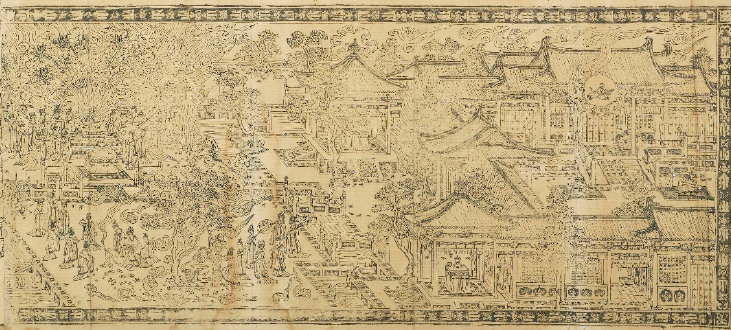
Figure 16. Imperial Commentary Vol. 21, Goryeo dynasty (11th century), 28.0 × 52.3 cm, Nanzenji